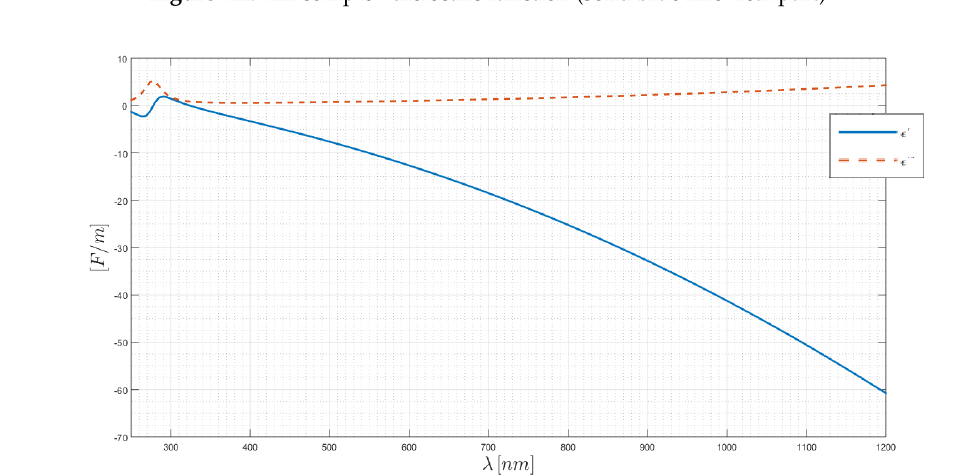
Figure A1. Air complex dielectric function (solid blue line: real part).